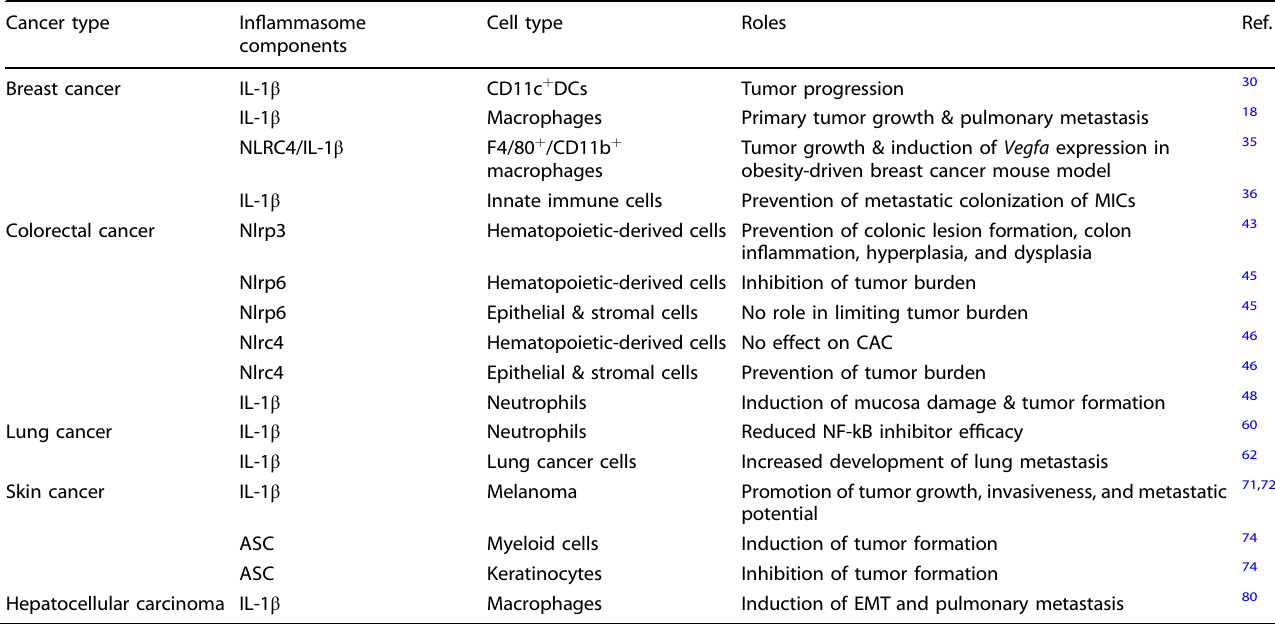
Table 1. Effects of cell type-dependent expression of in fl ammasome components in tumor microenvironment. Cancer